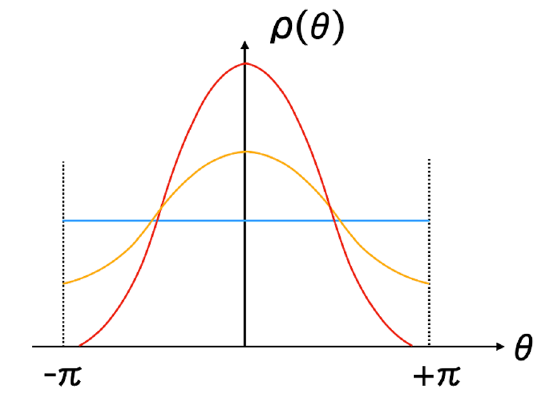
Figure 2. The distributions of the Polyakov line phases in each phase. The blue, orange and red lines are the completely-confined, partially-deconfined and completely-deconfined phases, re- spectively. The specific form of the distribution function ρ ( θ ) for the partially and completely deconfined phases depends on the theory under